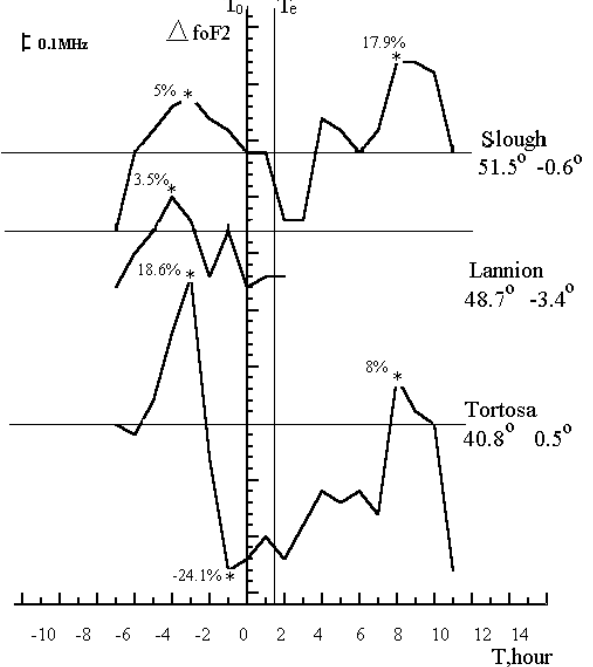
Fig. 7. The variations of 1 fo F2 values for the negative substorm that occurred on 27 March 1999 ( T o = 22:00UT or 22:00LT, I = − 110nT, τ = 1 . 5h) through the second (southern) longitudinal chain of stations of the IDCE, LT = UT. The vertical lines mark substorm onset, T o , and the end of the substorm, T e . Asterisks are δ fo F2 (%)